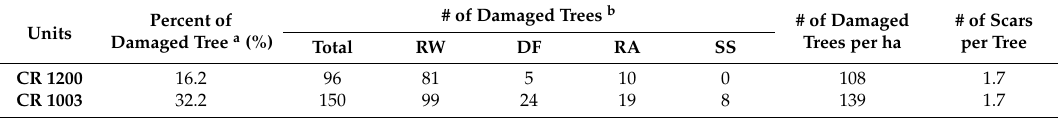
Table 3. Summary of residual tree scars resulting from CTL operations in each unit.